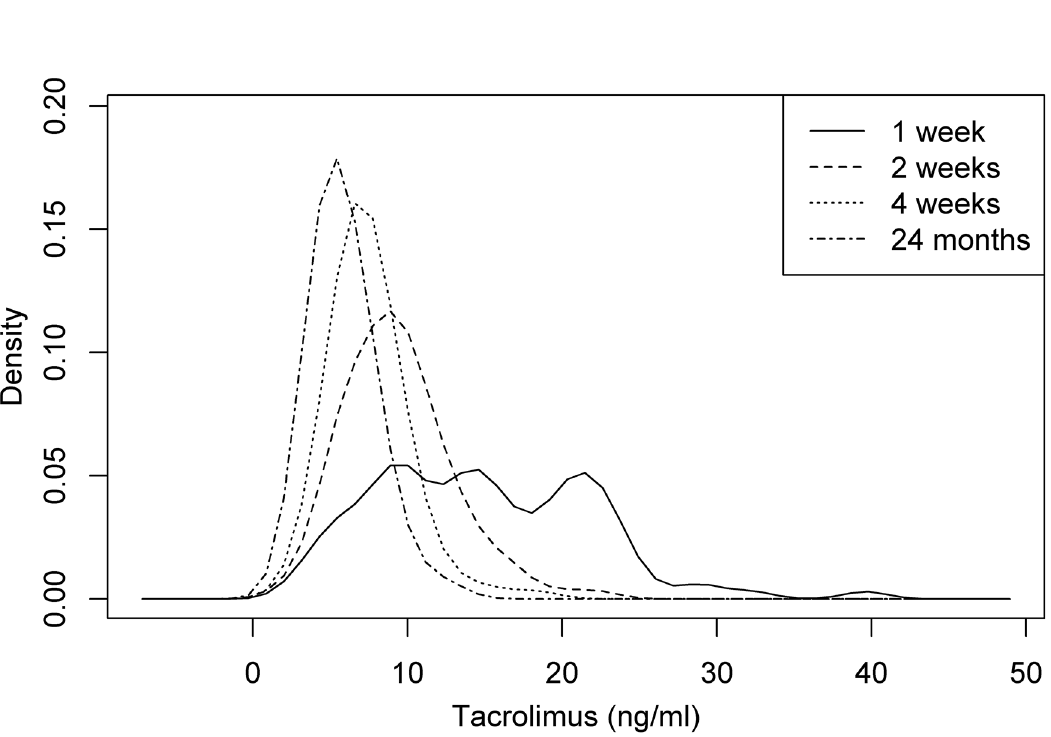
Fig 4. TAC trough level distributions at different follow-up timepoints. Tacrolimus trough level distributions at 1, 2 and 4 weeks, as well as, 24 months after conversion shown as density plots.